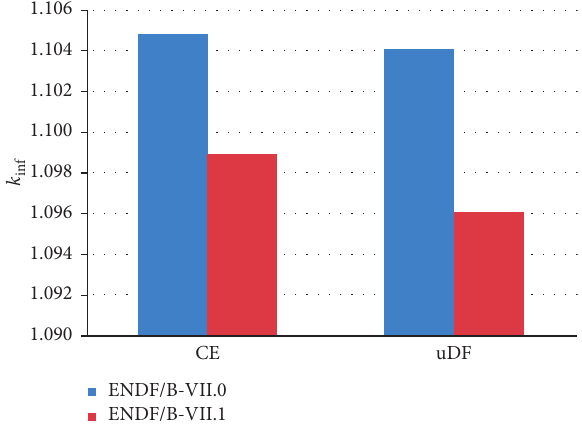
Figure 7: Neutron multiplication factor: comparison of CE and uDF cases.